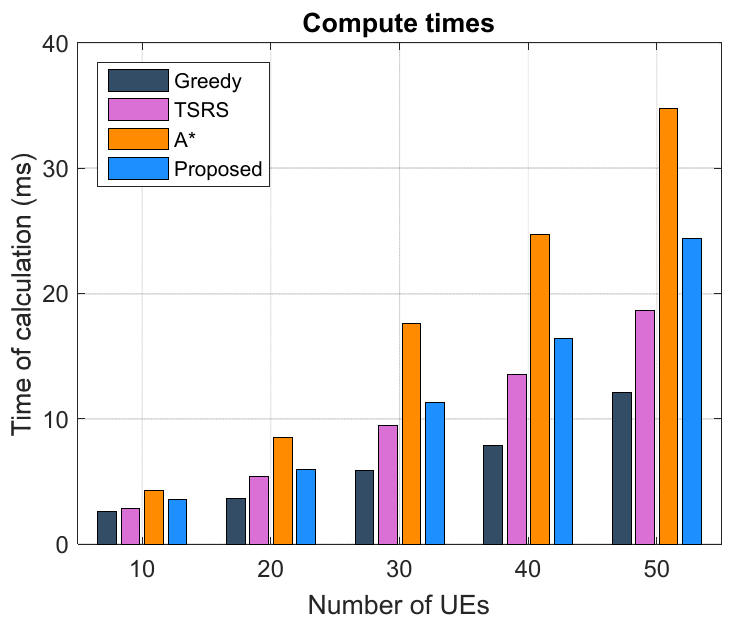
Figure 21. Execution time vs. number of UEs.